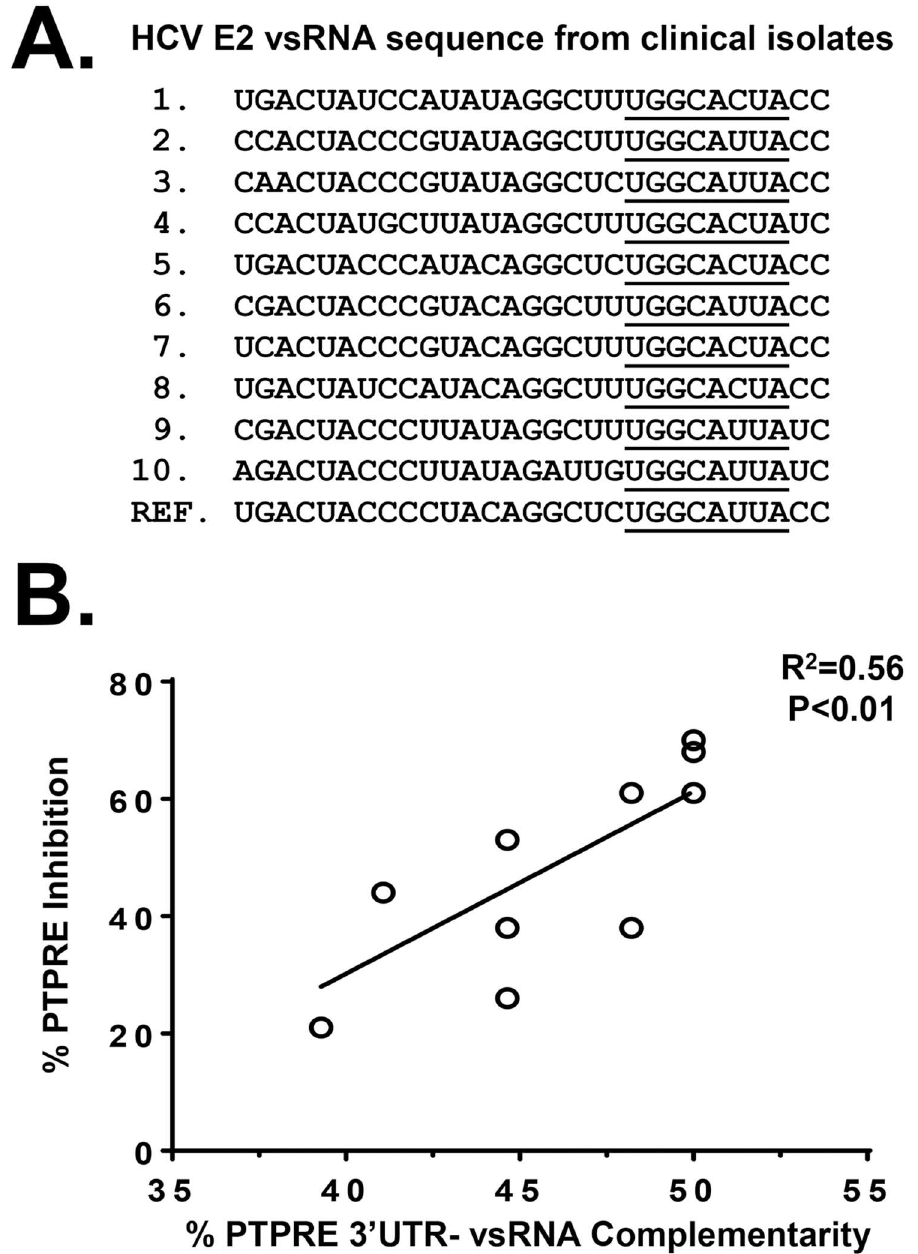
Fig 8. HCV vsRNAsequence polymorphisms correlated with PTPRE inhibition in vivo . HCV E2 RNA was amplifiedfrom plasma obtainedfrom ten HCV-infected subjects and the vsRNA regionwas sequenced (A). The putative “seed” sequencefor PTPRE is underlined. PTPRE expressionlevels correlatedwith the percent complementarity betweenthe HCV vsRNA and the two PTPRE 3’UTR target site sequences (Spearmancorrelation used to calculateR and P values, and results of best-fit linear regressionanalysisare shown). Ref = reference sequencefrom infectiousHCV